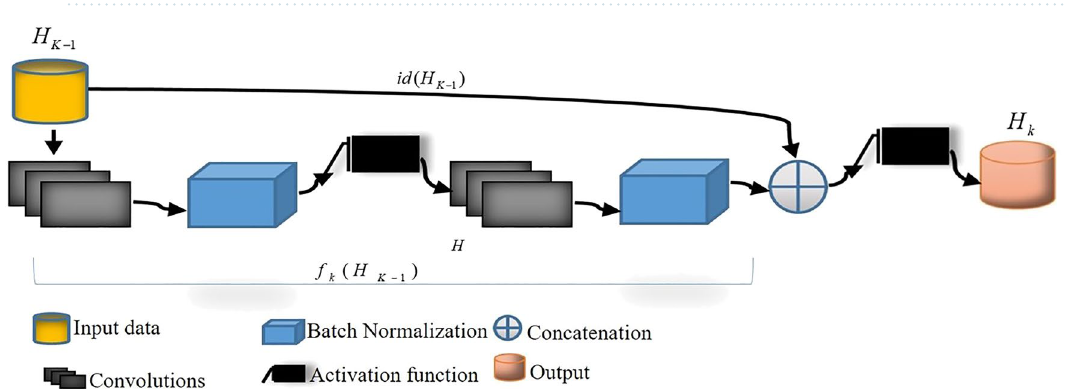
Figure 1. Overview of the proposed double attention Res-U-Net architecture.